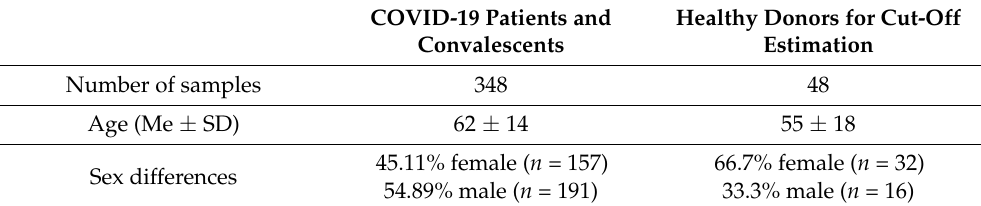
Table 1. Demographics of study participants.